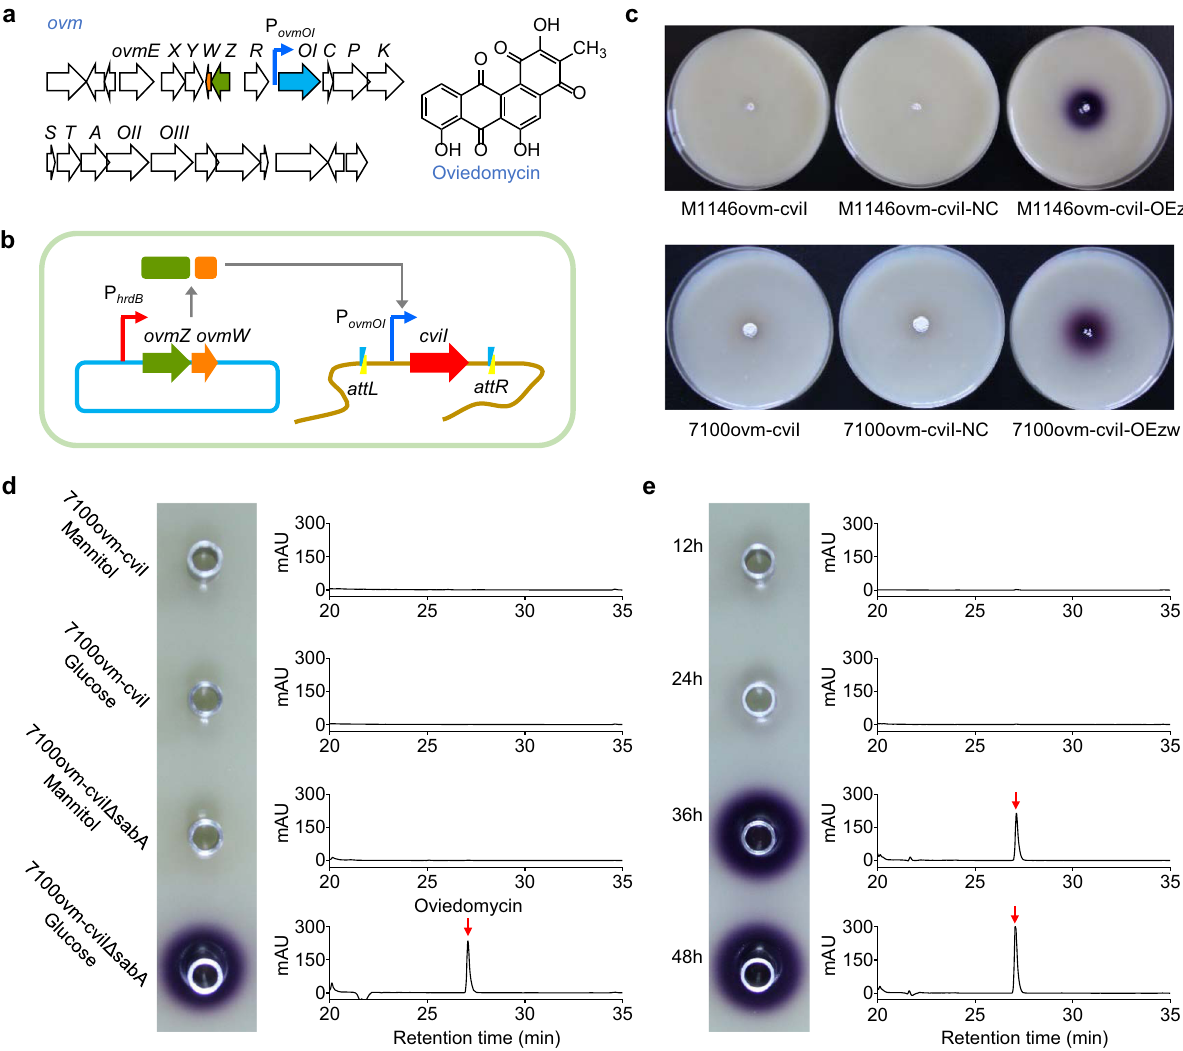
Fig. 2 Characterization of genetic regulation of ovm gene cluster guided by VRS-bAHL. a Genetic organization of oviedomycin biosynthetic gene cluster ( ovm ) in S. ansochromogenes 7100 and its chemical structure. b Schematic illustration of VRS-bAHL in detecting the activation of ovmOI promoter (P ovmOI